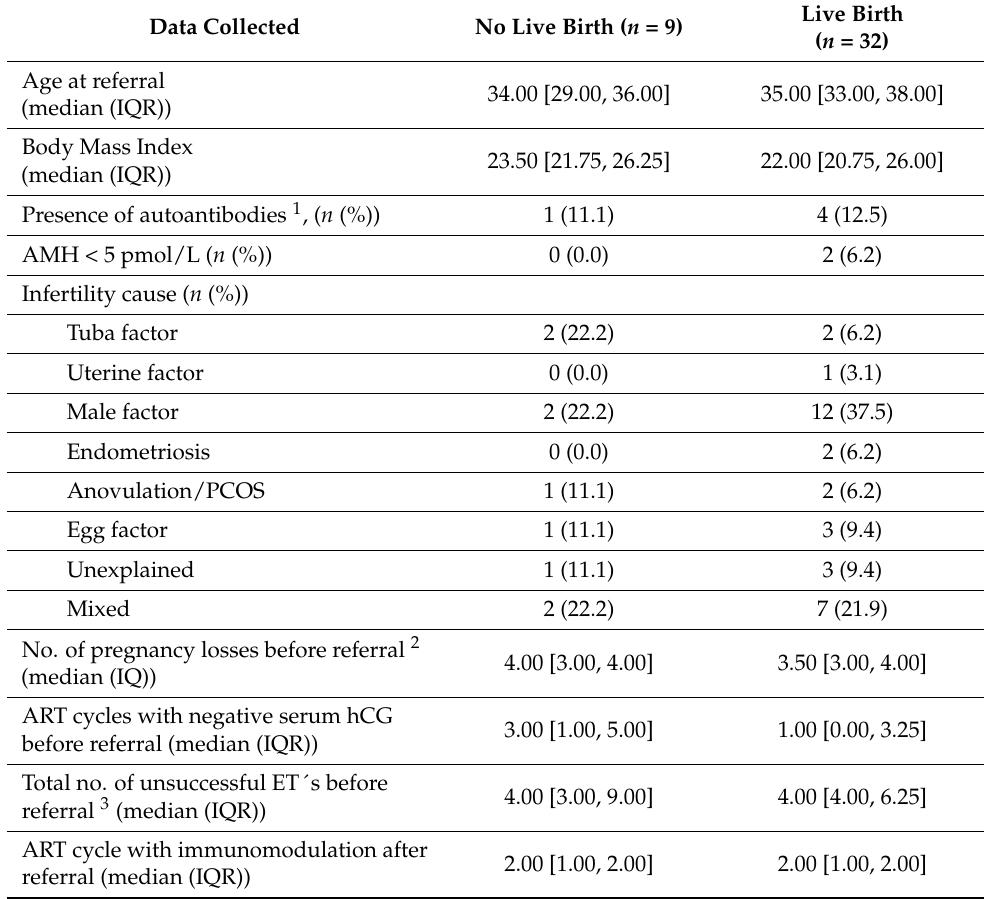
Table 1. Characteristics of the women with live birth and no live birth, respectively. Data